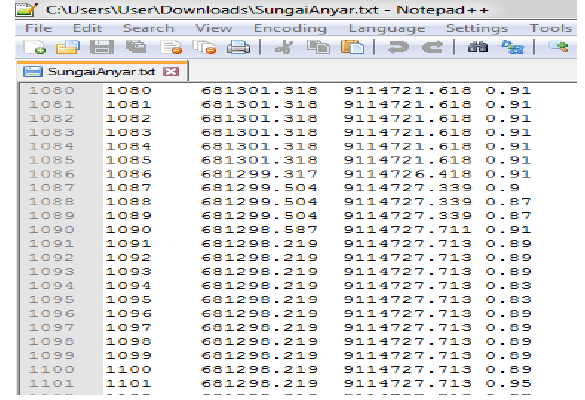
Figure 14. After correction (+ve signed of riverbed elevation).